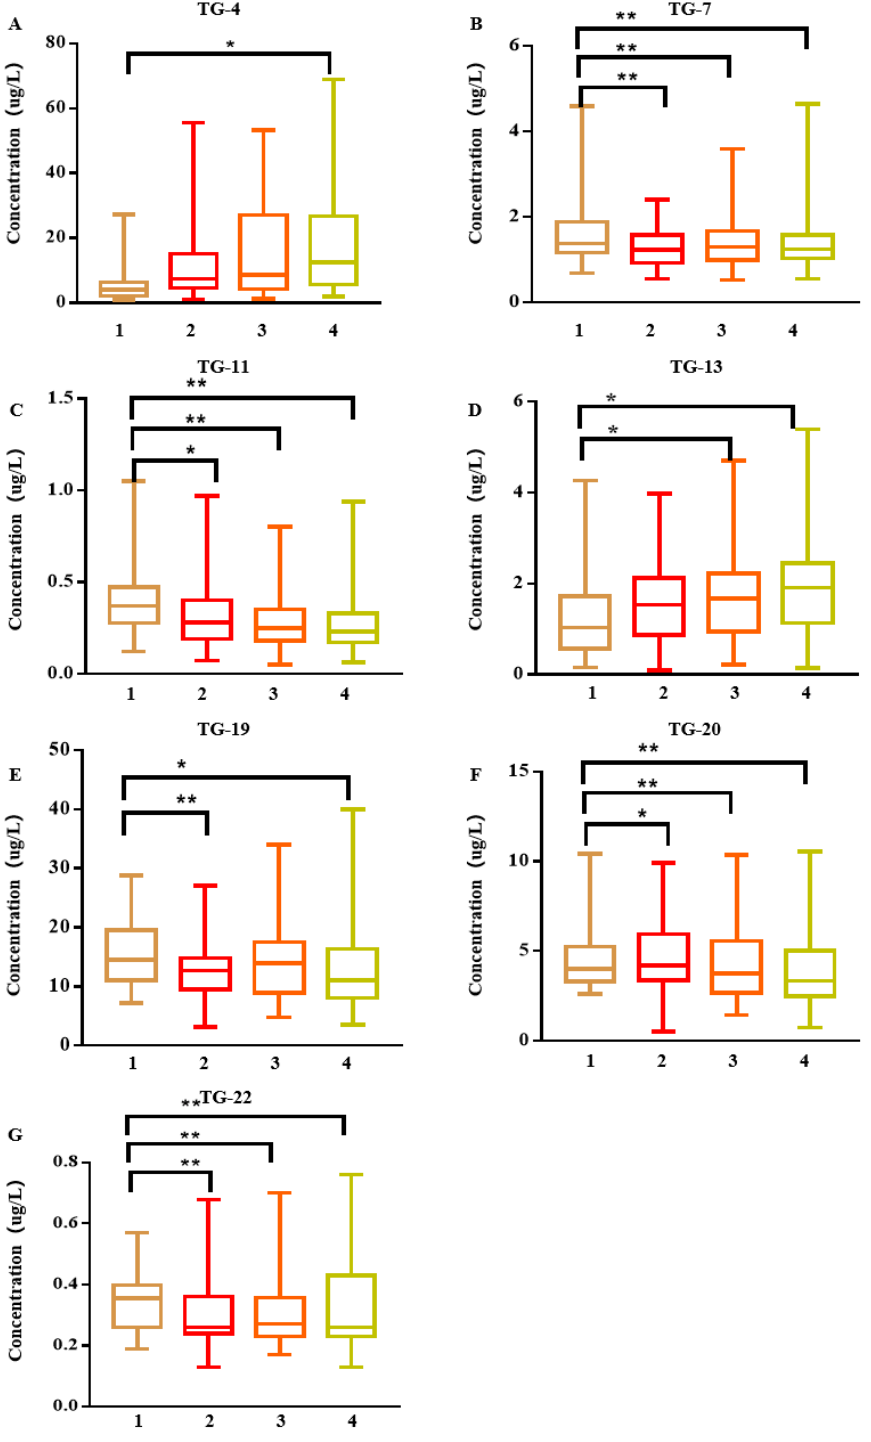
Figure 2. ( A – G ), 1, control; 2AIS; 3, MIA; 4, IAC. Box and whisker plots of the measured concentra- tions of TG-4, TG-7, TG-11, TG-13, TG-19, TG-20, and TG-22 in the exhaled breath 1 h after meals of the study groups, (least significant difference test) LSD-t analysis of variance. * p < 0.05; ** p < 0.01. (NB: All the data from AIS, MIA, and IAC are before